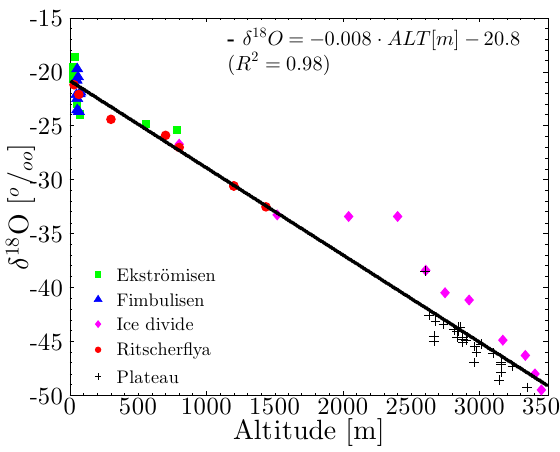
Figure 3. Core average δ 18 O plotted vs. core site altitude. Solid black lines show the respective linear fits to the data. Cores from different regions of the study area are shown in different colours and